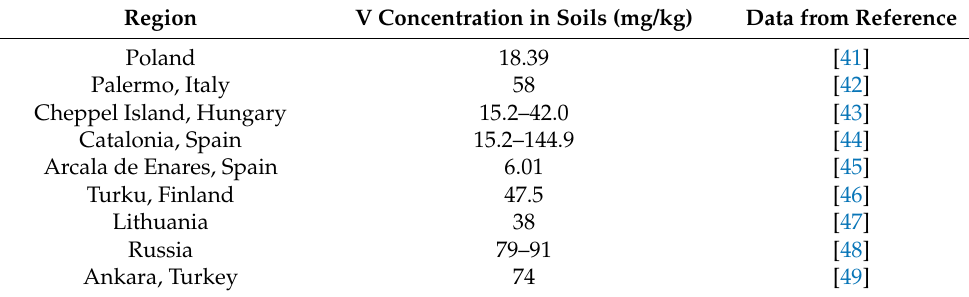
Table 1. V concentrations in some countries of the world. Region V Concentration in Soils (mg/kg) Data from Reference